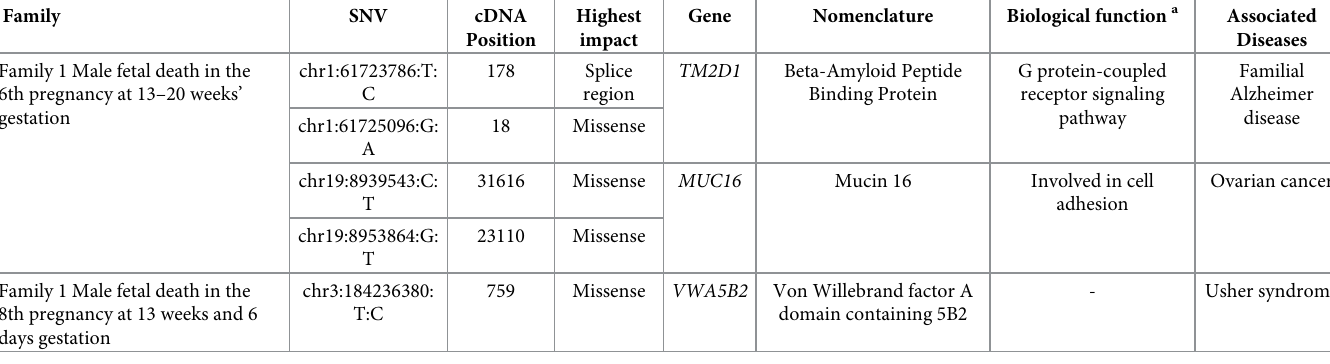
Table 3. Compound heterozygous SNVs identified in losses but not live births and gnomAD controls.